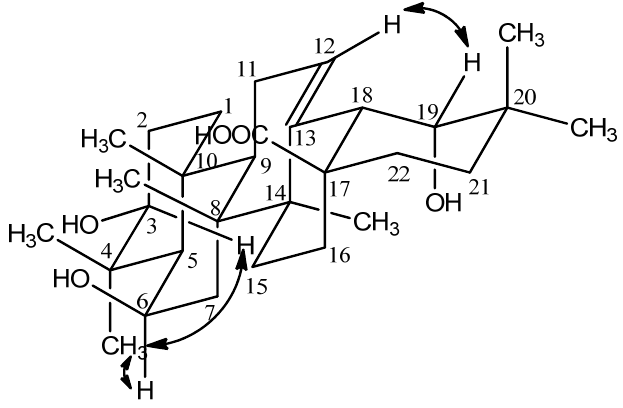
Figure 3. Selected NOESY correlations of compound 1